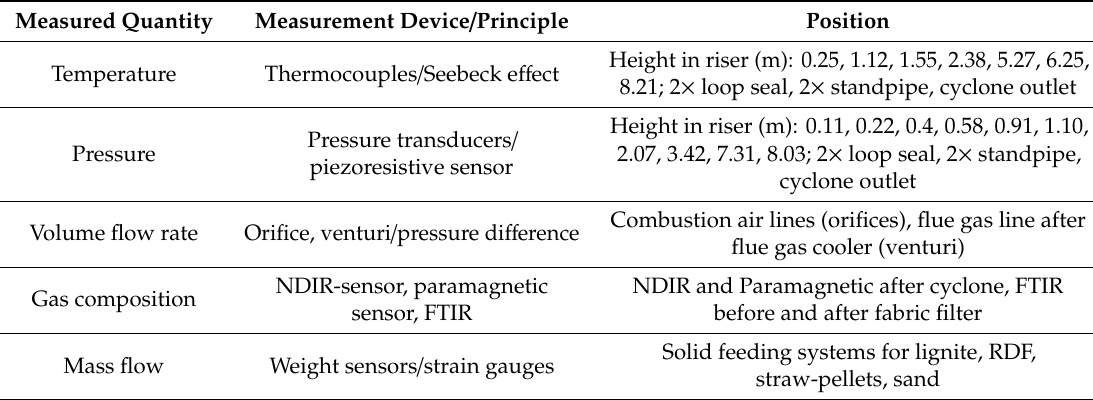
Figure 1. Flow scheme and 3D-model of the 1 MW th combustor pilot plant. Table 1. Measurement devices of the CFB pilot plant.